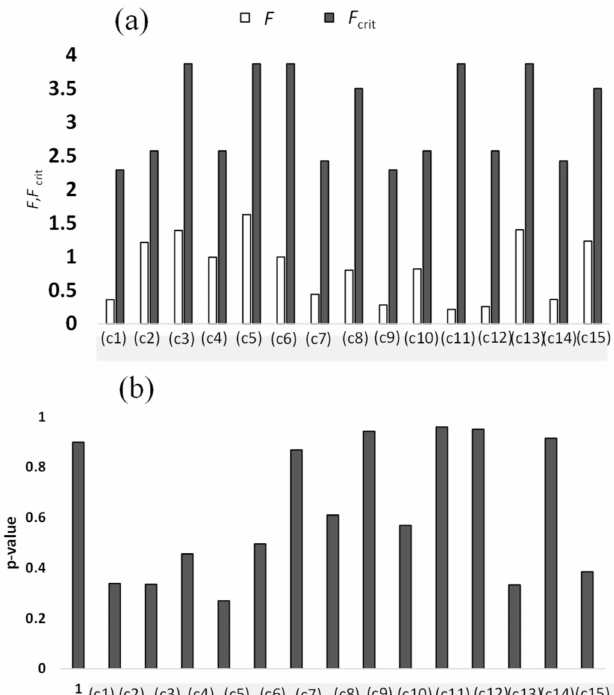
Figure 11. The numerical results of the ANOVA for the treatments shown in Tables 1–3 of ( a ) F and F crit and ( b ) p